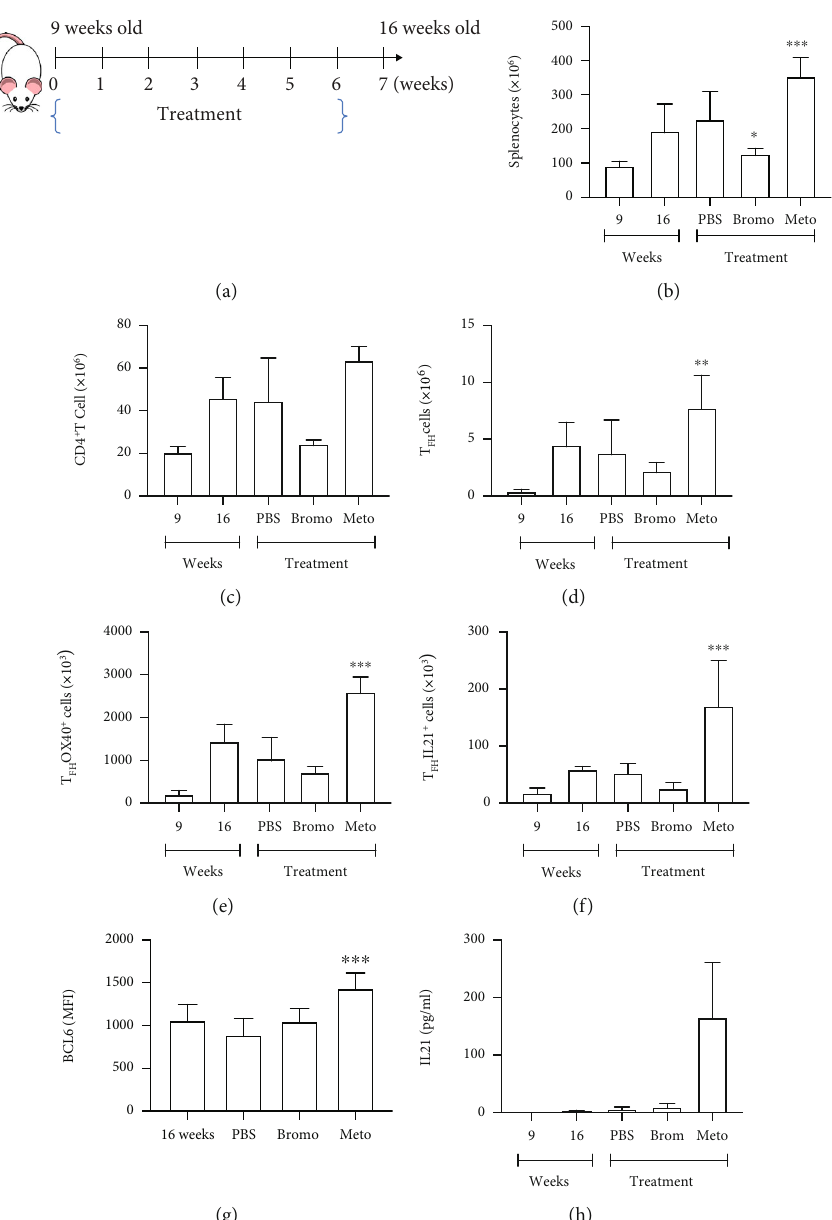
Figure 3: Metoclopramide increases the absolute number of T populations in MRL/lpr mice. Nine-week-old MRL/lpr mice were treated FH with metoclopramide (meto), bromocriptine (bromo), or PBS or were left without intervention (left column marked by age in weeks) for 6 weeks. (a) Flow chart of treatment strategy. At the end of the treatment, cells were labeled with anti-CD4, anti-CXCR5, anti-PD1, anti- OX40, anti-BCL6, or anti-IL21 antibodies. The graphs show the absolute number of (b) splenocytes, (c) CD4 + T cells, (d) T cells, and (f) IL21 + T cells. (g) Expression of BCL6 in T cells. (h) IL21 concentration in serum. For the determination of OX40 + T FH FH FH T IL21 + , the cells were stimulated with stimulation cocktail (PMA ionomycin) for 5 h and then stained. MFI: mean fl uorescent intensity. FH Eight mice per condition were used. Pooled data are presented as the mean ± SD ; ∗∗∗ p < 0 : 001 , ∗∗ p < 0 : 01 , and ∗ p < 0 : 05 using